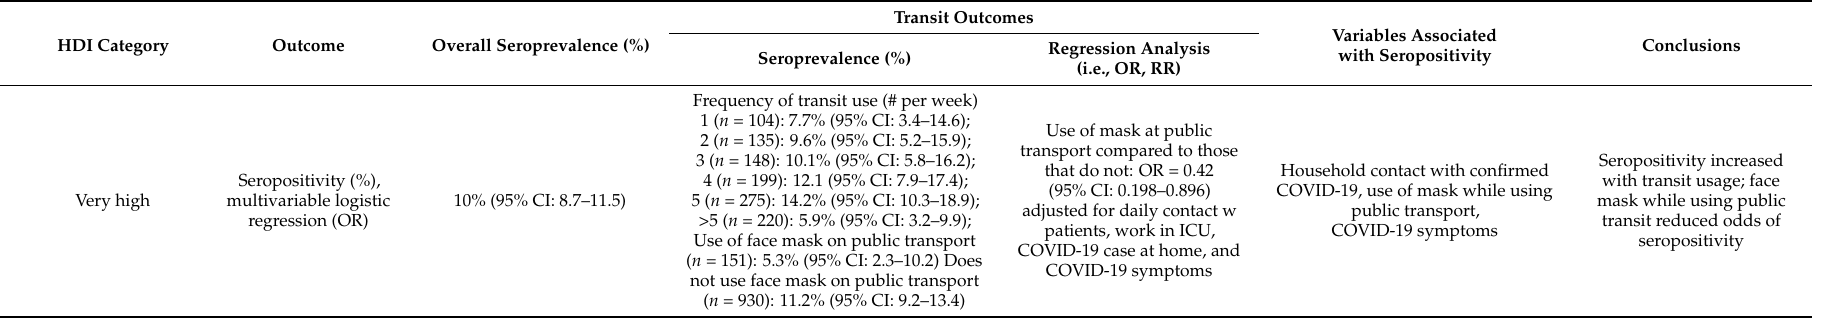
Table 3. Summary of findings from studies that assessed the association between seropositivity and use of public transportation in healthcare workers from highest to lowest